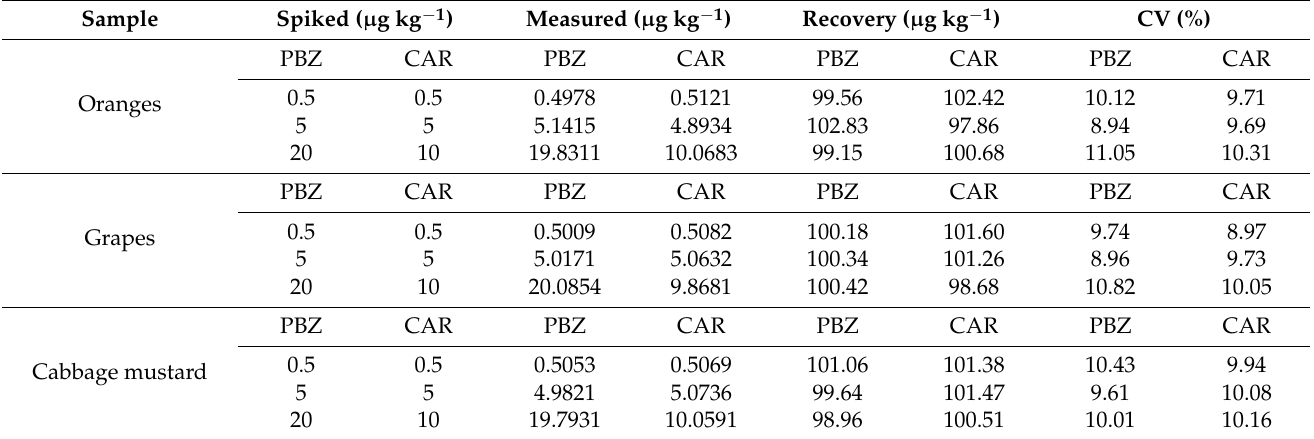
Table 2. Results of recovery experiment ( n =